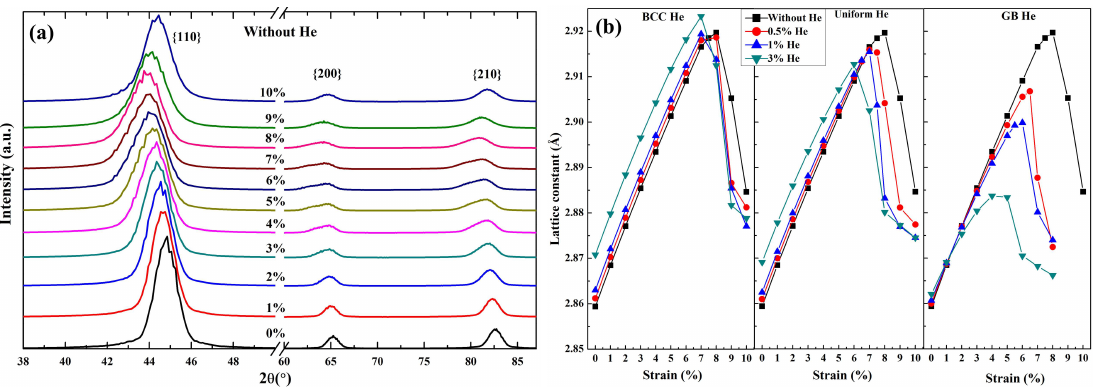
Figure 10. ( a ) Simulated XRD patterns of pure nanocrystalline BCC-Fe at the strain range from 0% to 10%. ( b ) The lattice constant of models under the tensile stresses are plotted as a function of